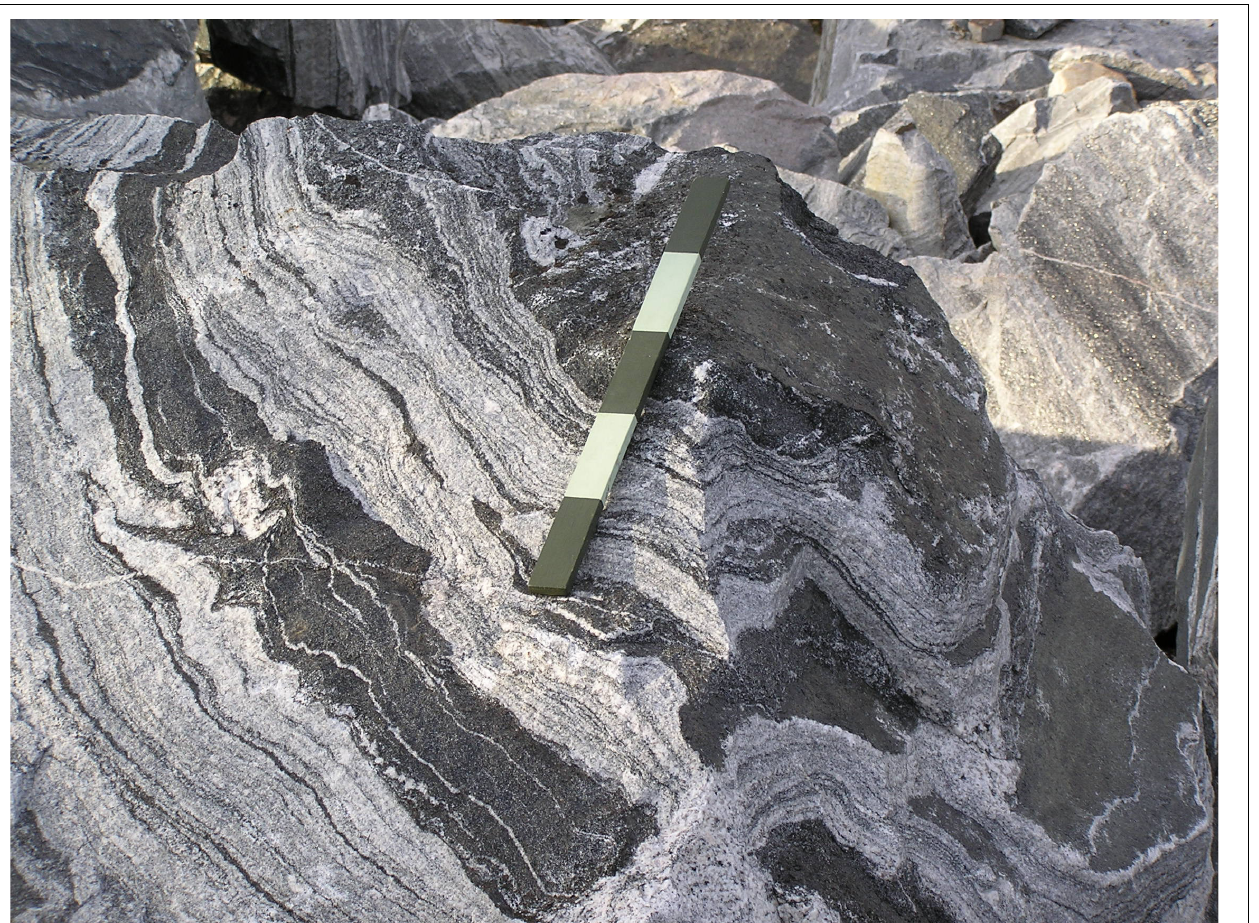
FIGURE 11 | Folded raft diatexite, Näätämö, Lake Inari Complex of the Kola Craton, NE Finland. Deformation and folding separates and stretches rafts of amphibolite. Photo: Pekka Kivimäki.